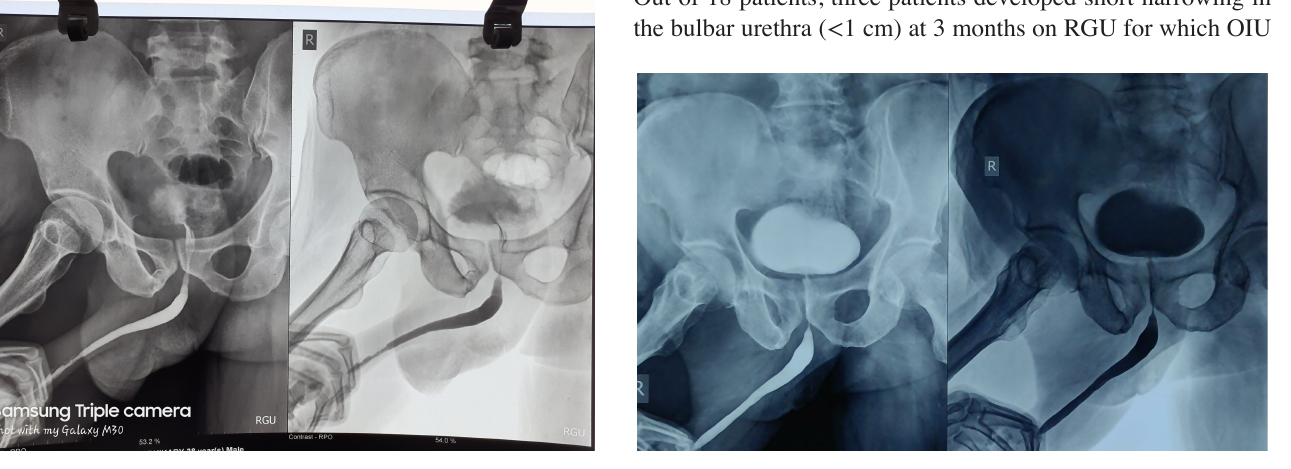
Figure 3. Postoperative retrograde urethrogram showing normal urethral